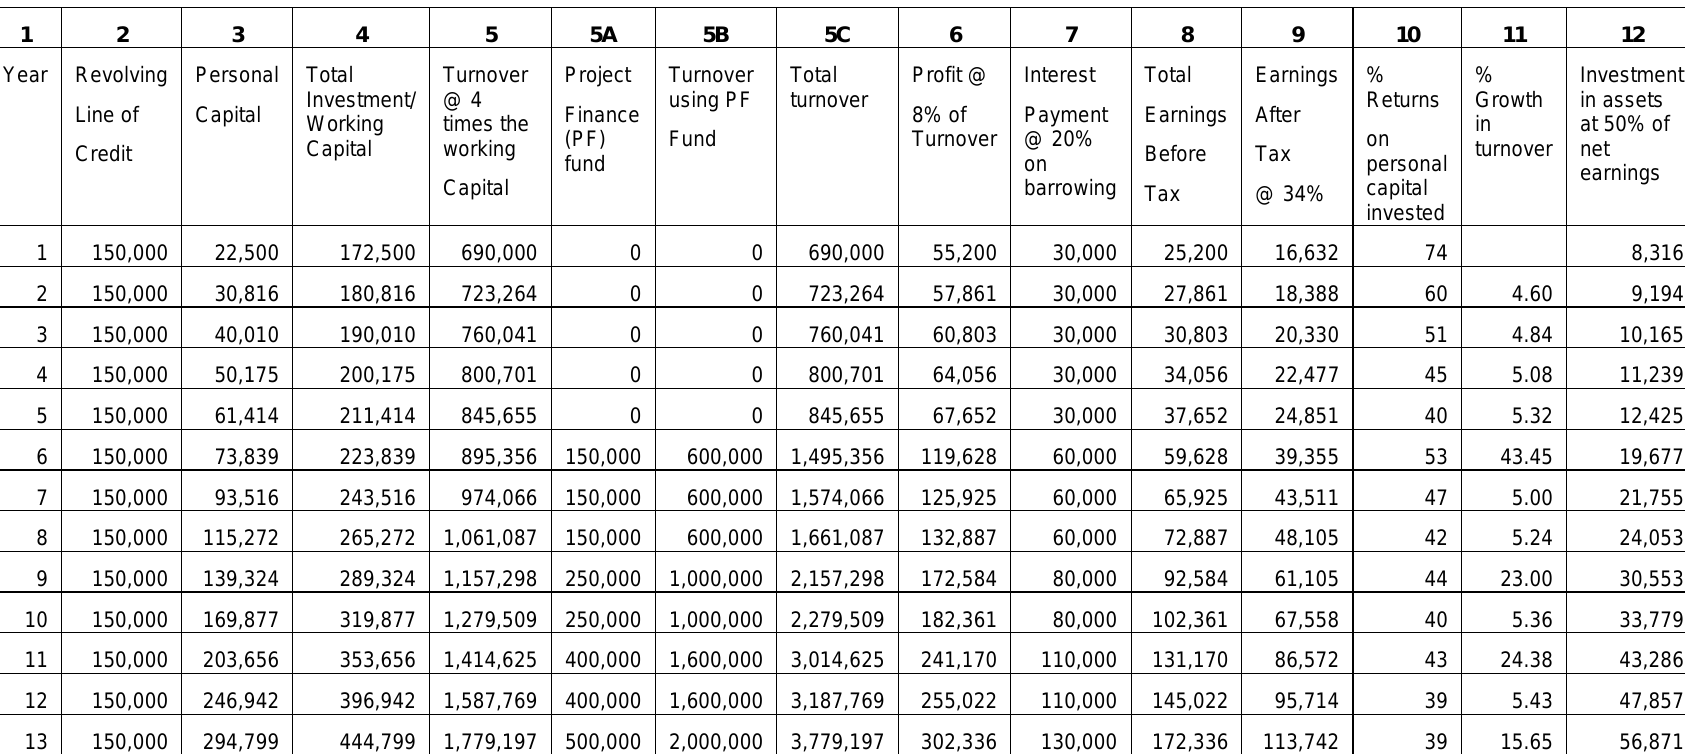
Table 2 : Company funded by the Project Finance